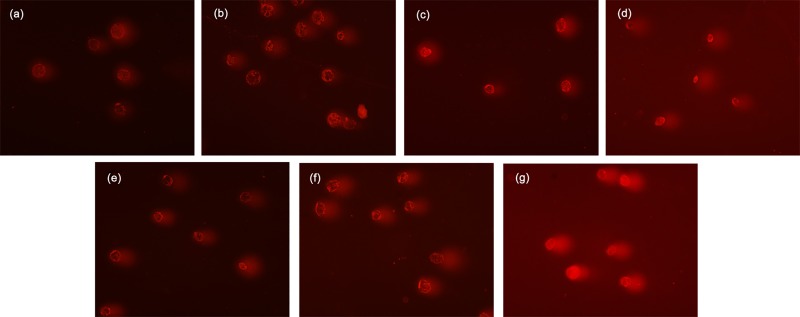
Comet assay of T. thermophila cells after koumine exposure.(a) Blank control; (b) negative control (NC) and koumine added at (c) 0.05 mg/mL; (d) 0.1 mg/mL; (e) 0.2 mg/mL; (f) 0.4 mg/mL; (g) 0.8 mg/mL. Magnification was 20×.